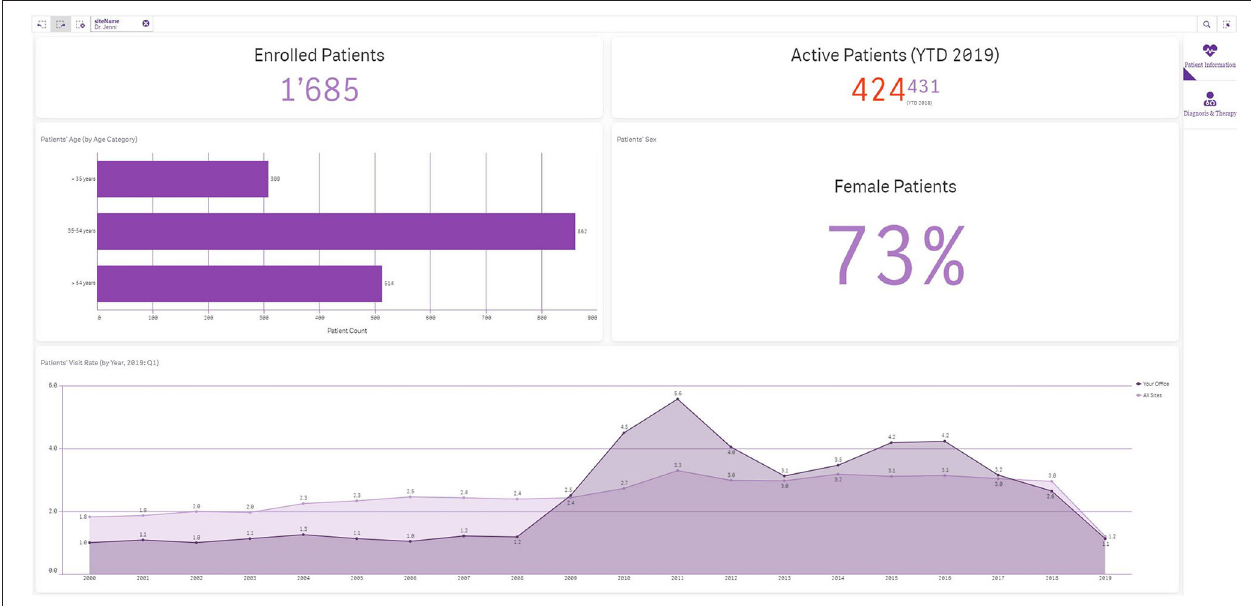
FIGURE 5 | Information Cockpit for doctors.